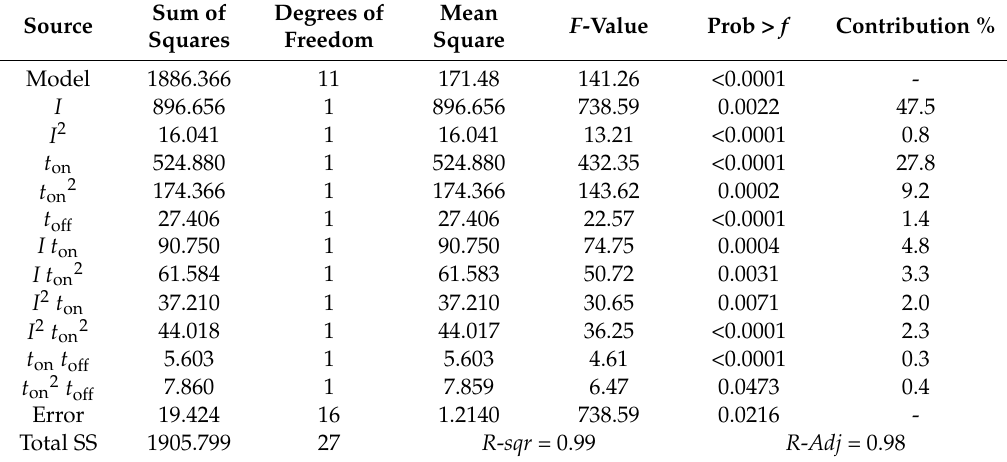
Table 7. The ANOVA table for the maximal thickness of the white layer (after elimination).